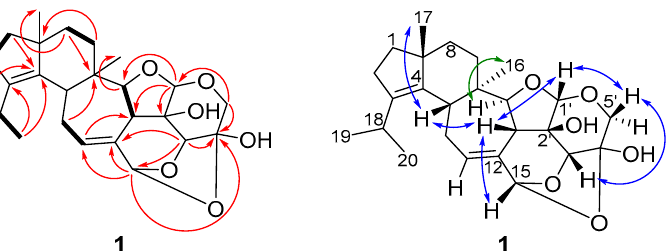
Figure 2. Key NMR correlations of dentifragilin A ( 1 ). Bold bonds: 1 H, 1 H COSY correlations; red arrows: 1 H, 13 C HMBC correlations; blue arrows: 1 H, 1 H ROESY correlations, indicating β -orientation; and green arrows: 1 H, 1 H ROESY, indicating α -orientation. Table 1. 1D and 2D NMR spectroscopic data of compounds 1 – 3.